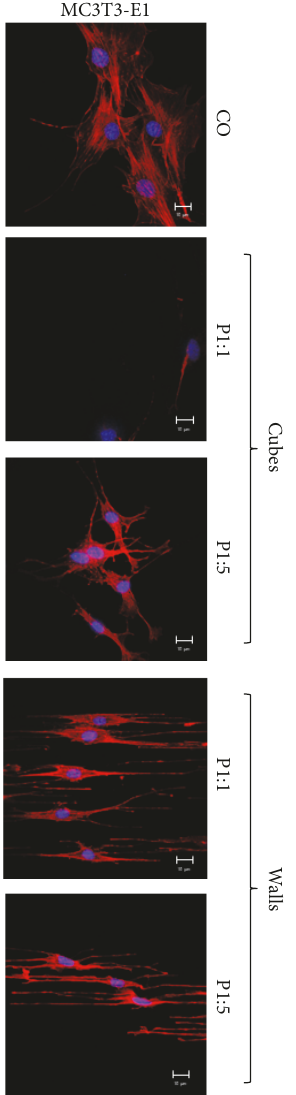
Figure 6: Cell morphology of MC3T3-E1 cells changes in response to the structured surface. LSM images of MC3T3-E1 cells on microstructures indicated on the right side. Scale bar=10 𝜇